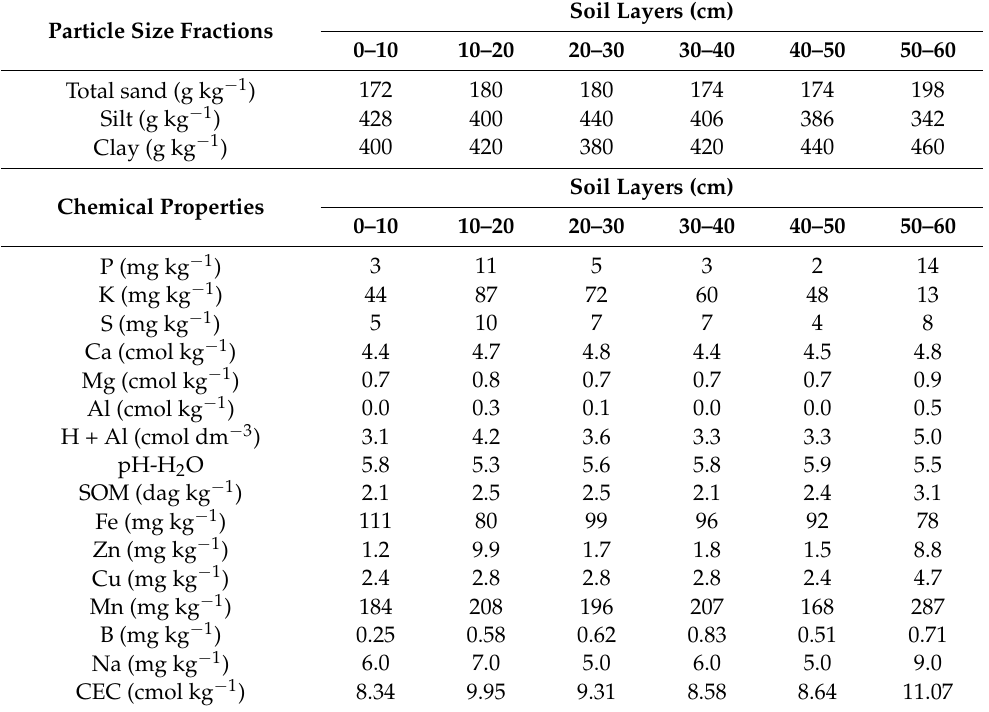
Table 1. Particle size and chemical properties of six soil layers in an irrigated area planted with Robusta coffee ( Coffea canephora ) in Alta Floresta D’Oeste, Rond ô nia,